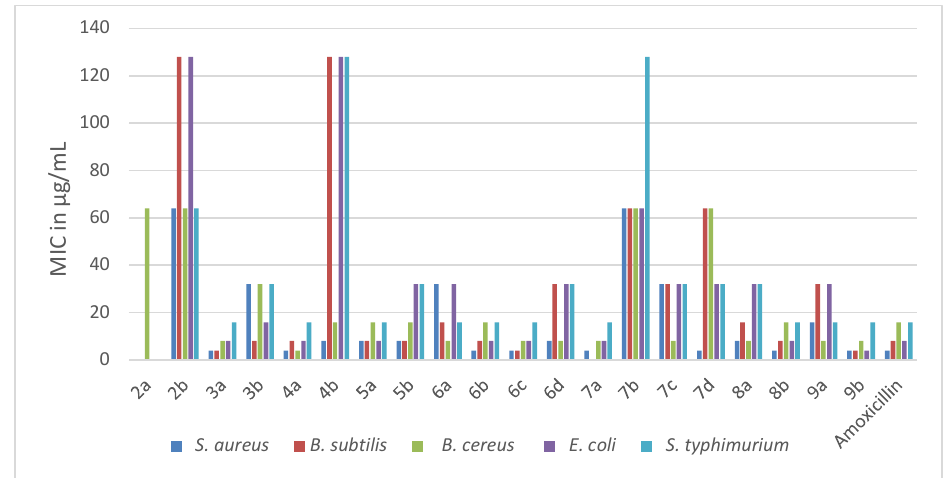
Figure 2. Antibacterial activities (MIC in µg/mL) of the new pyridothienpyrimidine compounds 2a,b–9a,b and the reference antibiotic (amoxicillin trihydrate).